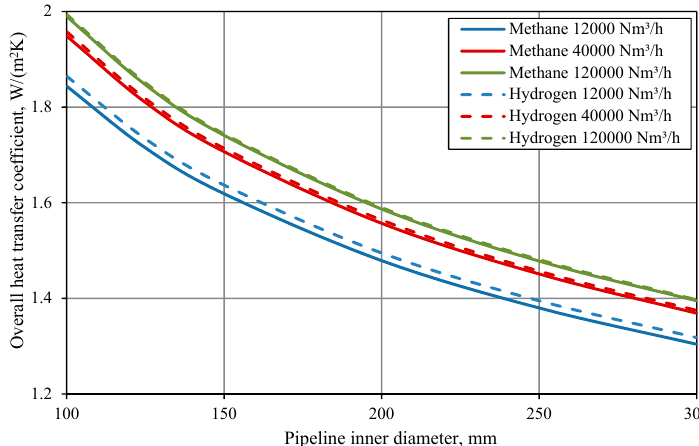
Figure 3. Overall heat transfer coefficient as a function of pipeline inner diameter for different flow rates of pure methane and pure hydrogen.